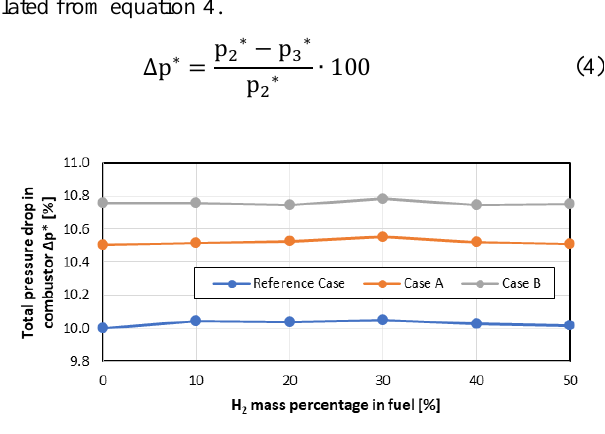
Fig. 8. Total pressure